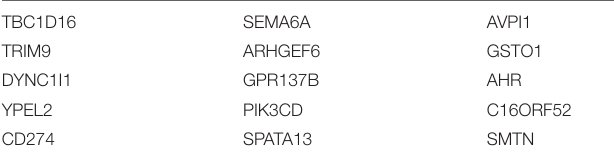
TABLE 1 | Top 15 genes for CCLE skin cell line